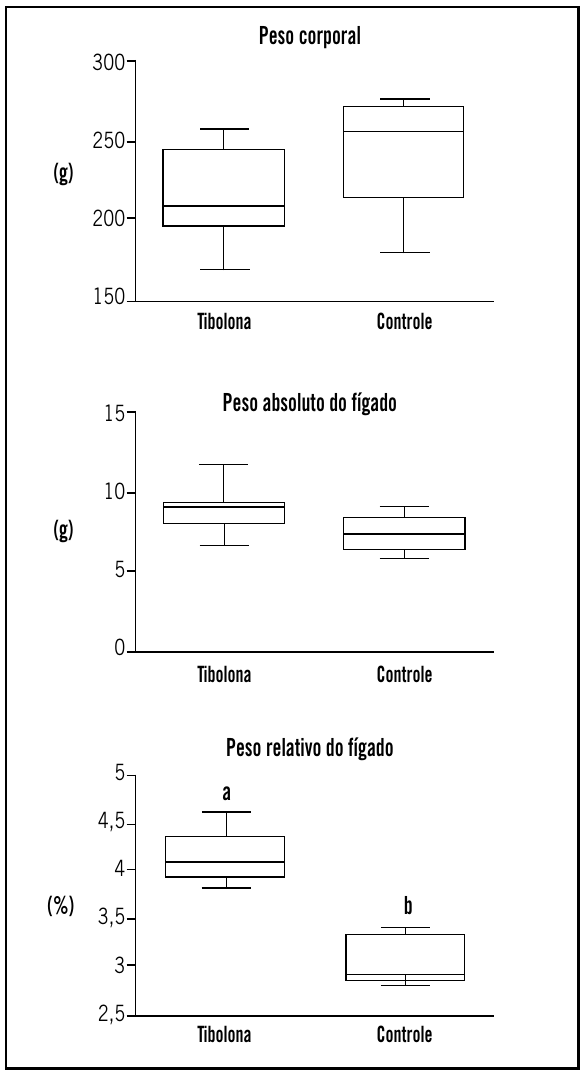
Figura 3 – Pesos corporal, absoluto e relativo do fígado Grupo tibolona ( n = 9) e grupo-controle ( n = 5). Boxplot da distribuição de dados mostrando a mediana, os quartis e os valores máximo e mínimo. Letras diferentes indicam diferença significativa. Teste de Mann-Whitney p <